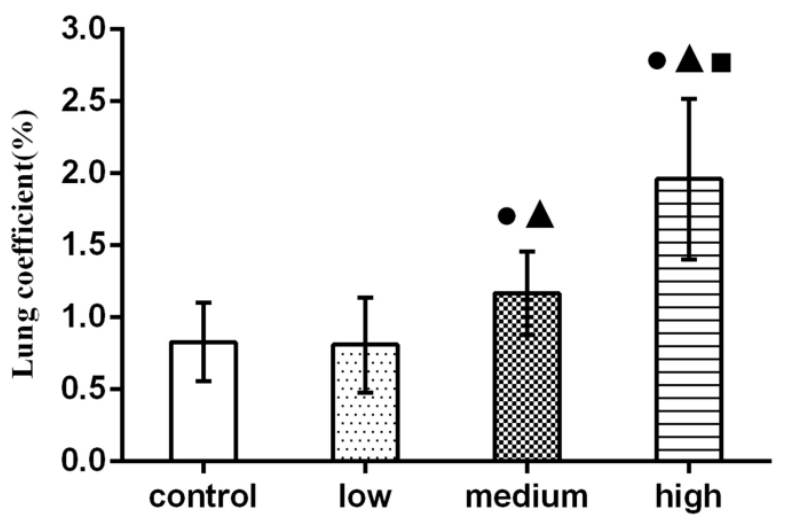
Figure 3. Effect of La 2 O 3 NPs on lung coefficient in rats. Note: ● , compared with the control group, p < 0.05; ▲ , compared with the low group, p < 0.05; ■ , compared with the medium group, p < 0.05. in the lung tissue of rats in medium- and high-dose groups increased significantly, and the content of lanthanum in the high-dose group was significantly higher than that in the medium-dose group and control group ( p <